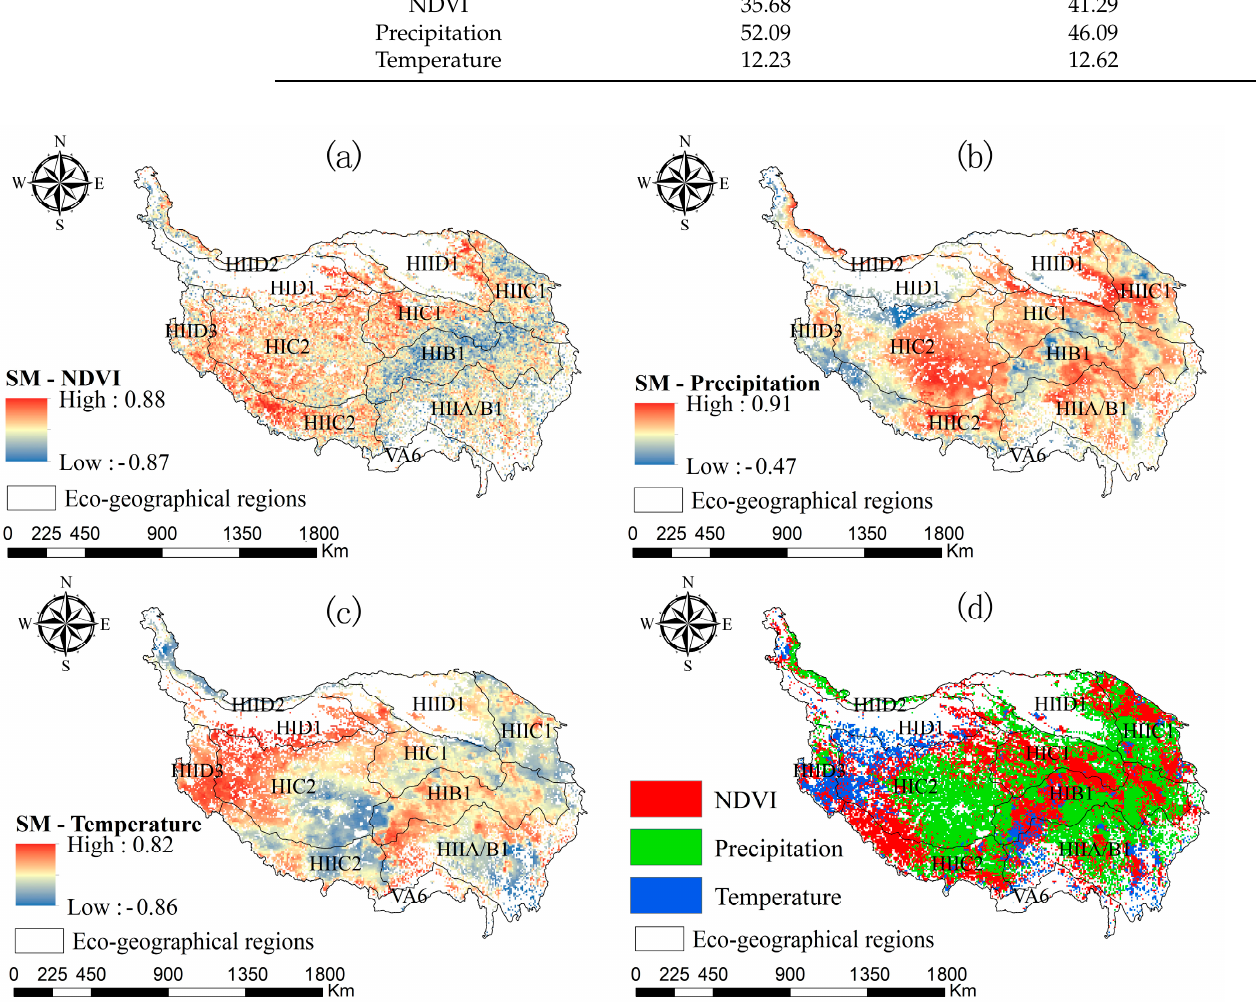
Figure 3. Partial correlation coefficients between ( a ) NDVI, ( b ) precipitation, ( c ) temperature and SM from 1982 to 2015, and ( d ) dominant factors influencing SM.